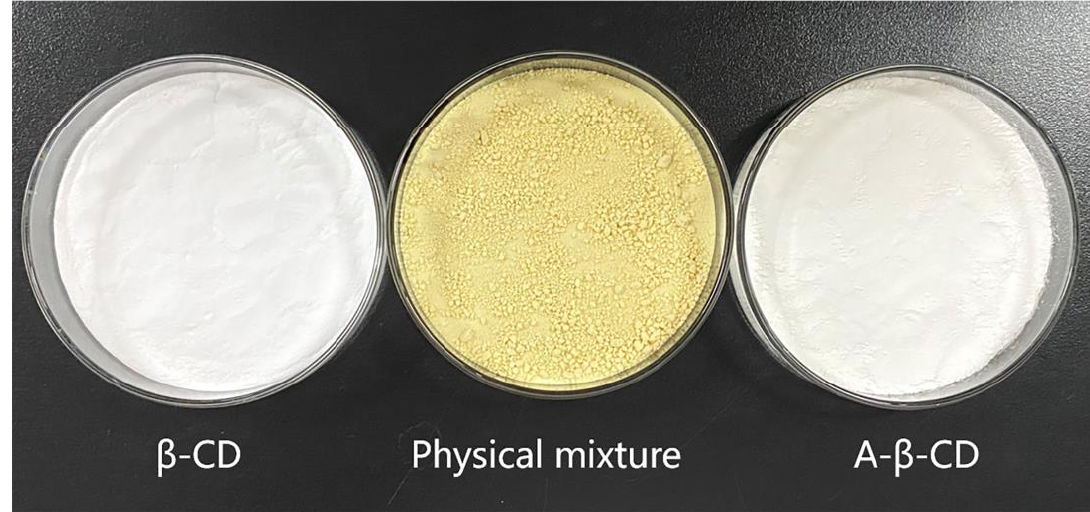
Figure 3. Photographs of β -CD, the physical mixture, and a- β -CD.